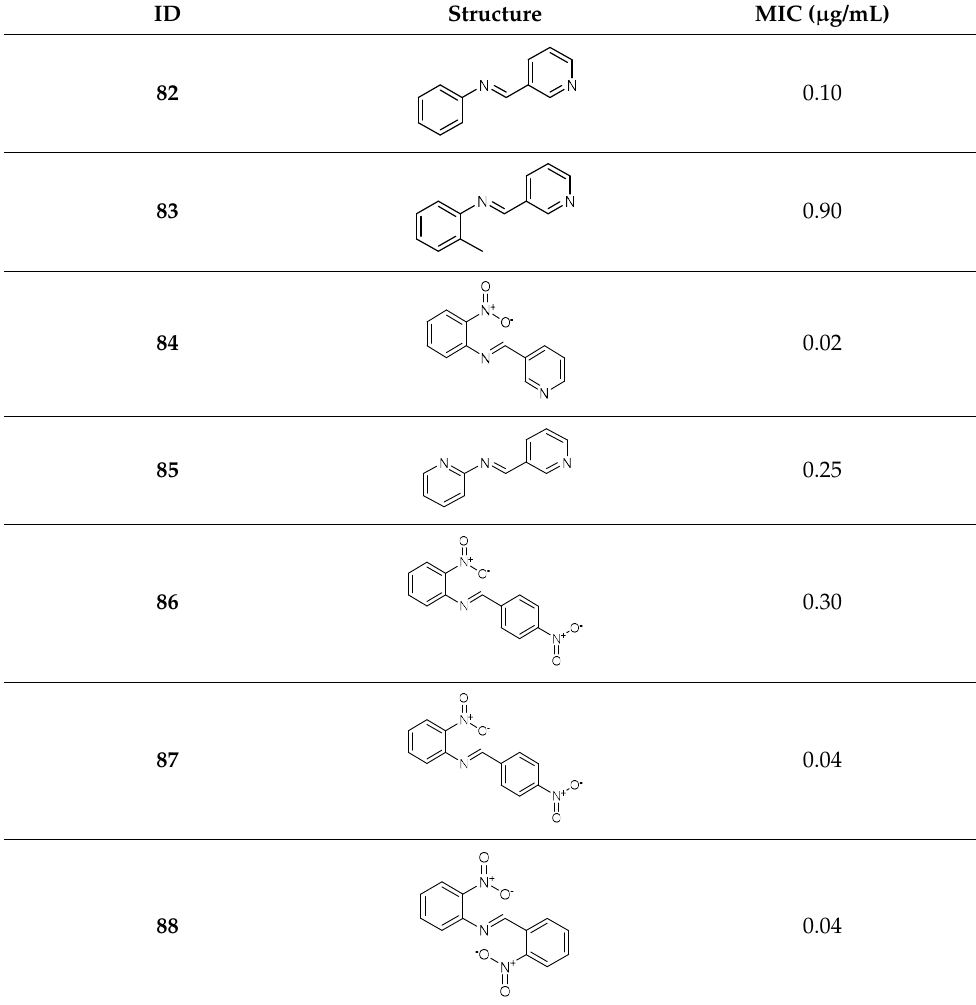
Table 11. M.I.C. values of Schiff base derivatives compounds tested against F.o.a.